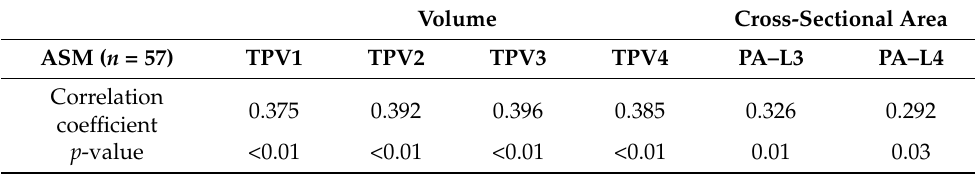
Table 2. Pearson correlation test between psoas muscle volume, cross-sectional area, and ASM.